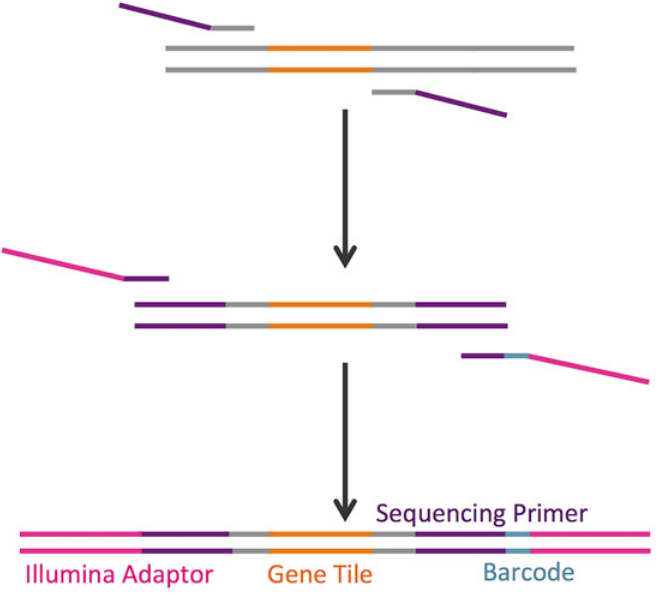
Fig 6. 2-step PCR method for deep sequencing preparation of libraries. PCR reactions are shown for two separate gene tiles containing single mutations (orange and green). Primers are designed to be complementary to flanking regions (grey) of each tile, with encoded single mutations. The first set of primers includes the flanking regions and Illumina sequencing primers (purple). In the next step, outer primers add the Illumina adaptor (pink) and multiplexing index (teal) sequences to the gene. The PCR reaction is performed in a single tube using a 1:2 molar ratio of inner to outer primers and bead purified to remove primer dimer products. The purified library is ready for sequencing without further modifications. While the first set of primers is specific to a single gene tile, the outer primer set is